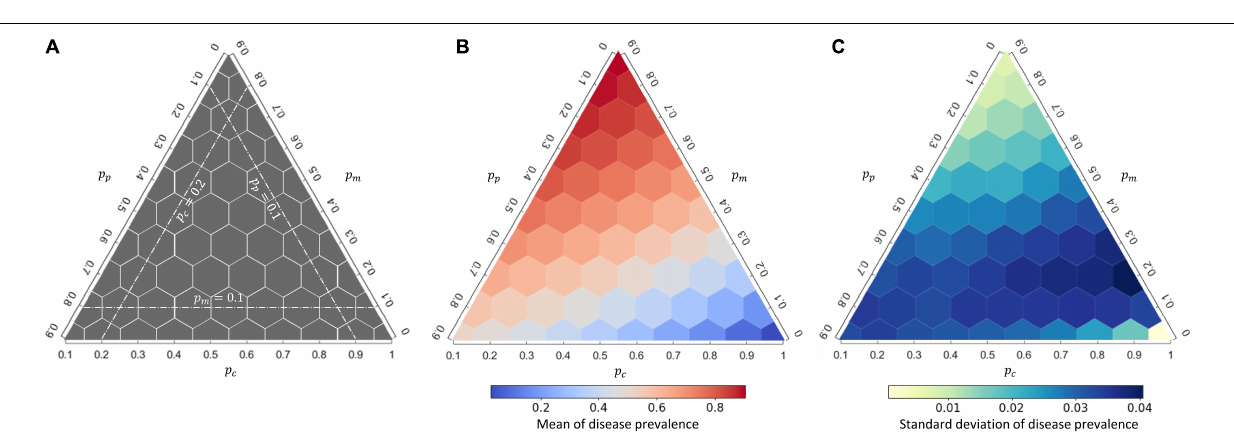
FIGURE 2 | The response of disease prevalence at the community level to interaction composition under density-dependent (DD) disease transmission. (A) A schematic guide to read the ternary plot. The three white dashed lines represent the interaction composition when the proportion of the specified interaction type held constant. The center of each hexagon represents a single interaction composition examined (55 in total); (B,C) the mean and standard deviation of the response for each interaction composition, calculated from 1,000 replicates. See Supplementary Figure 5 for the corresponding figure under frequency-dependent (FD)